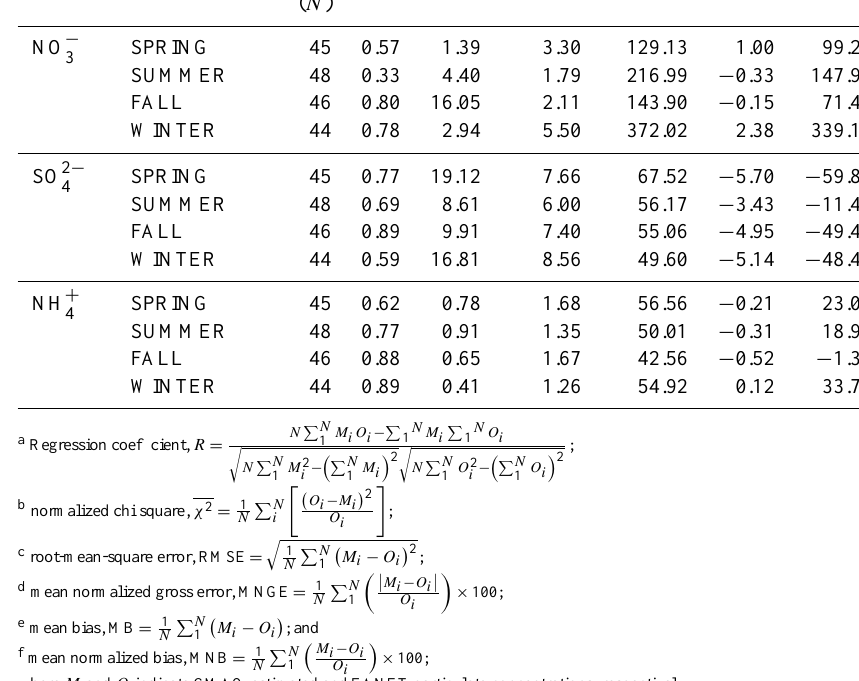
Table 1. Statistical values between CMAQ-estimated and EANET/CAWNET-derived particulate concentrations of NO − for the four seasons of 2006.